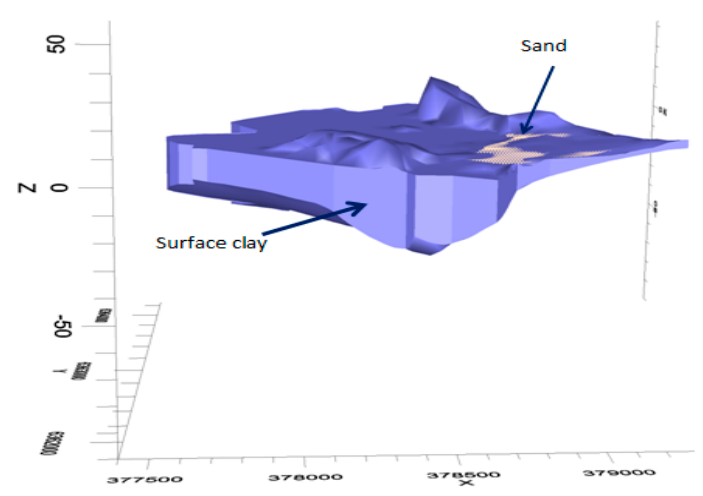
Figure 7. Hydro-stratigraphic units in the original groundwater model.